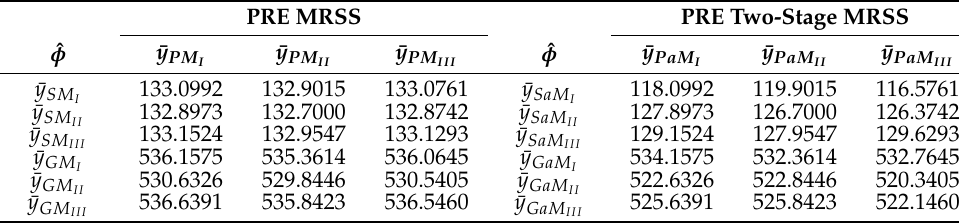
Table 5. PRE values for ( A 1 , B 1 ) .